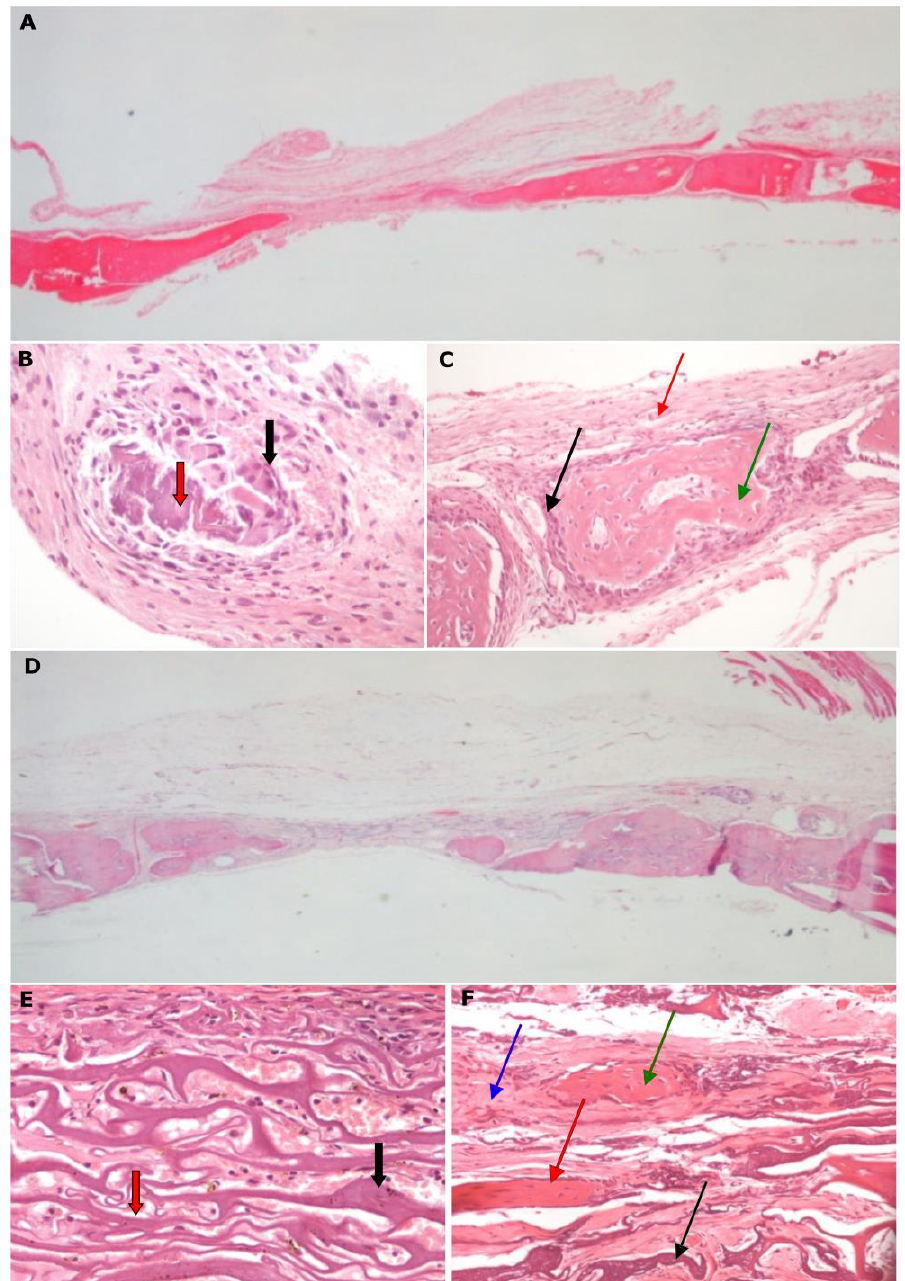
Figure 5. Histological micrographs of groups A and B. ( A ) Group A3, magnification x20: ossification occurs/develops from periphery to center, which is occupied with fibrous connective tissue; ( B ) Group A1, magnification x400: presence of osteoclasts during necrotic tissue resorption (red arrow); ( C ) Group A1, magnification x200: newly formed osseous tissue (green arrow) surrounded by osteoblasts and a ring of fibrous connective tissue (red arrow); ( D ) Group B3, magnification x20: membrane is completely degraded and new bone has formed from periphery to center, which is occupied with fibrous connective tissue; ( E ) Group B1, magnification x400: presence of membrane (black arrow) without remarkable degradation of vasculature (red arrow); ( F ) Group B2, magnification x200: extended membrane degradation (black arrow), newly formed osseous tissue (green arrow) surrounded by osteoblasts (red arrow) and growth of fibrous connective tissue (blue arrow). Moreover, in the STS groups the systemic administration of simvastatin induced bone healing up to the second experimental week, but after this period, it resulted in a statistically significant bone loss (STS1 vs STS2, p = 0.007) (Figure 6A, B). This finding suggests an initially positive, but then a negative osteogenic effect of simvastatin when it is administered systemically. This action may be considered to be indirect as a result of the intense myopathy that was observed in the histological preparations (Figure 6C, D), or due to the development of inflammation in the peritoneal region where the drug was